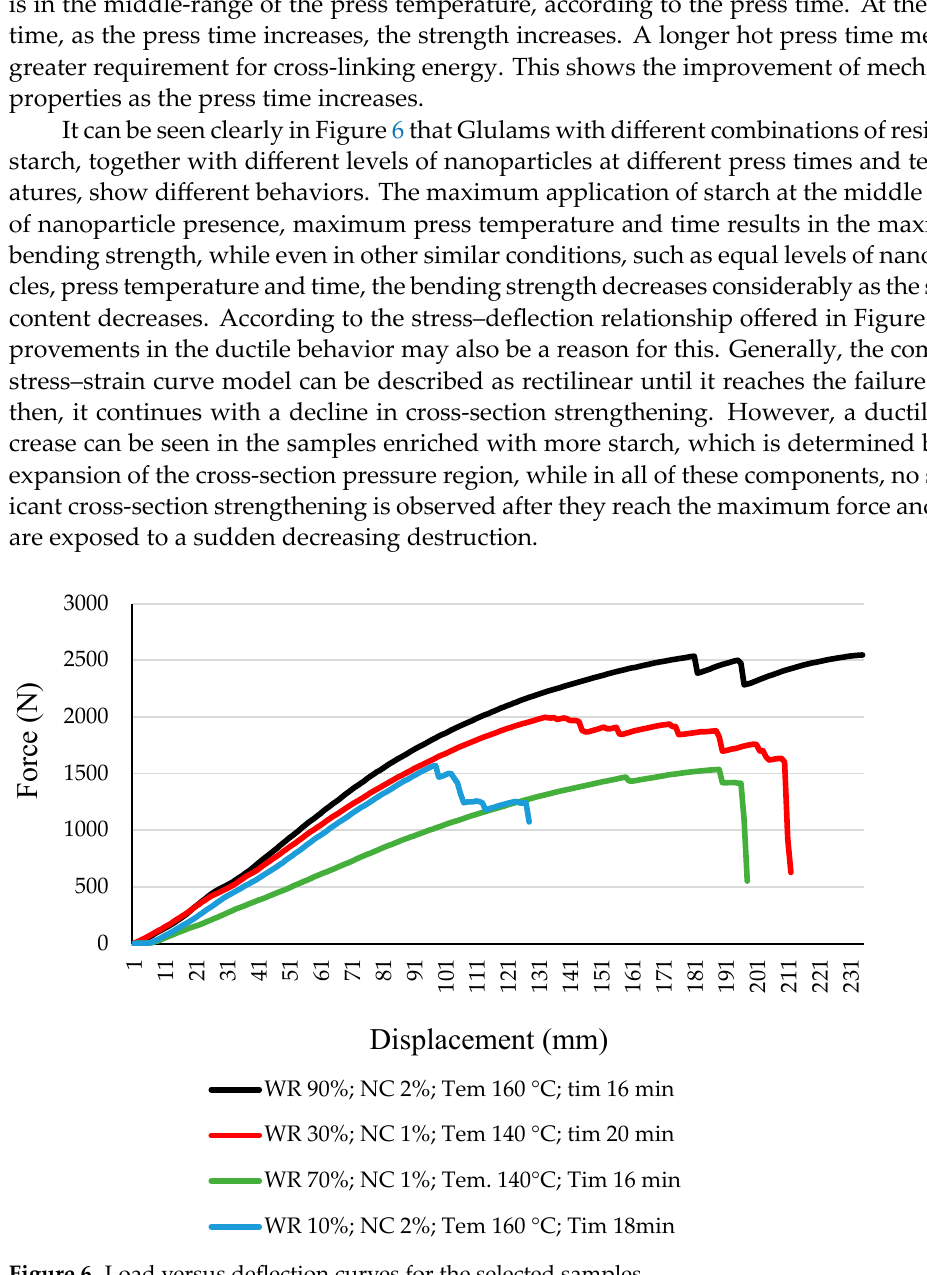
Figure 6. Load versus deflection curves for the selected samples.